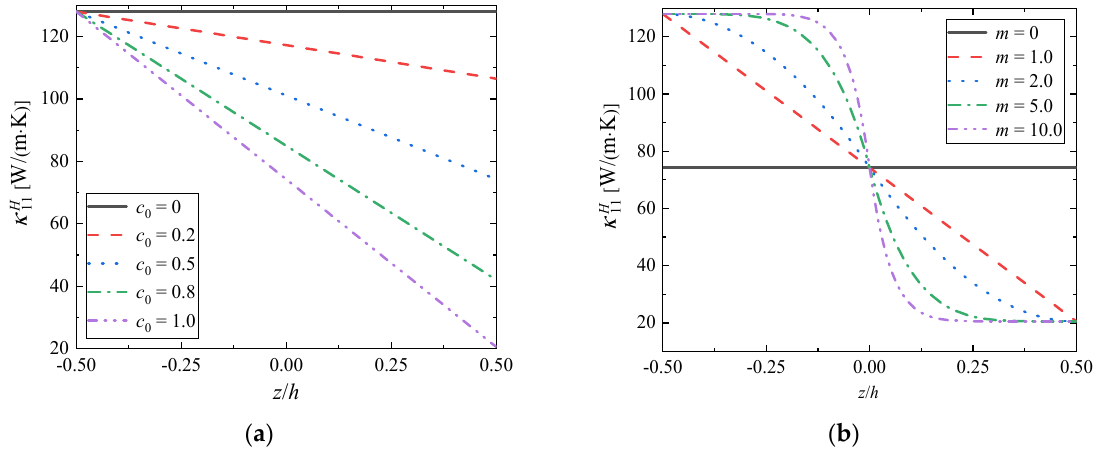
H along the gradient direction when ( a ) m = 1.0; ( b ) c along the gradient direction when ( a ) m = 1.0; ( b ) c 0 = 11 11